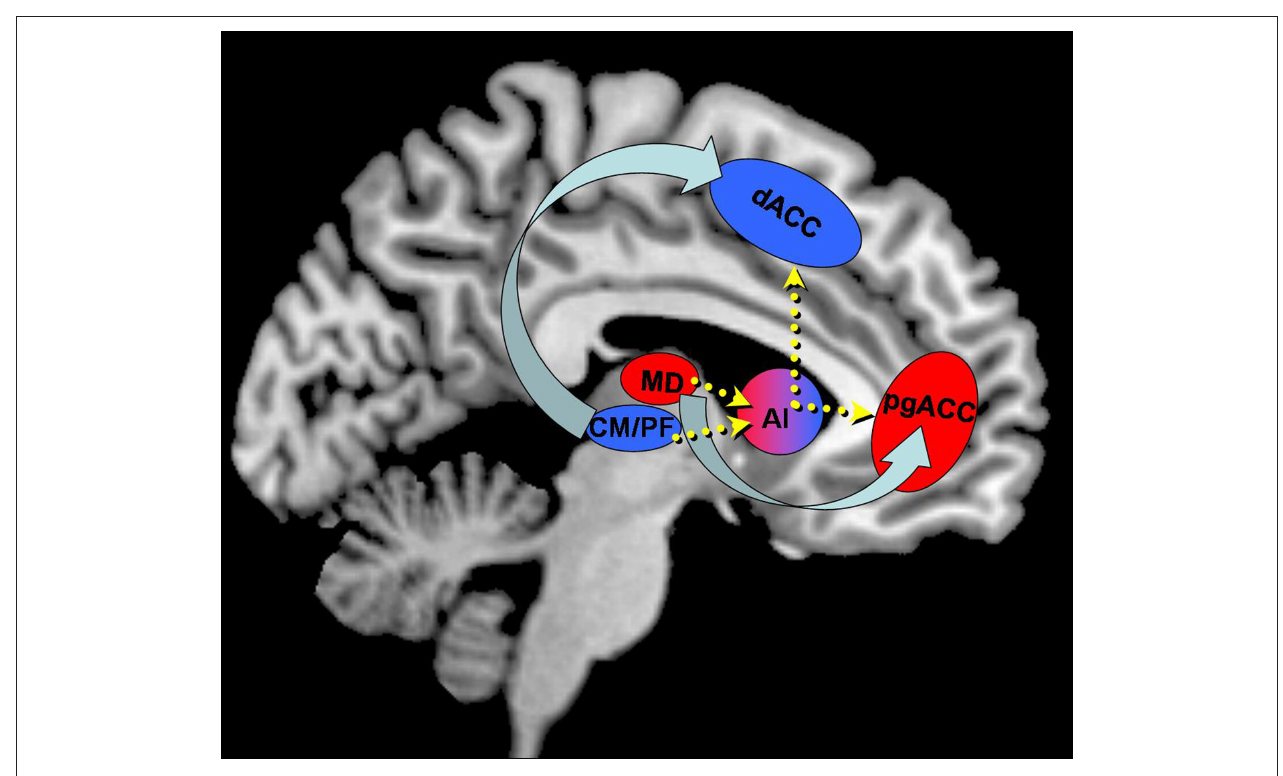
FIguRe 7 | Schematic representation of segregated and integrated processing of emotional and attentional dimensions during sexual stimulation. Distinct parcellations within thalamus reflect a rostro-caudal parcellation of ACC with direct connections of corresponding portions. The anterior insula (AI) may serve as an integrator with connections to both networks thus orchestrating functionally distinct processes. Arrow width does not indicate the strength of